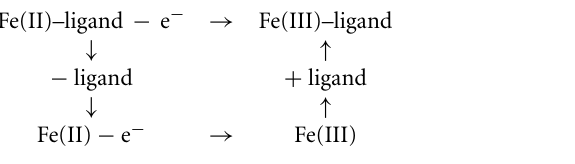
FIGURE 9 | Linear free-energy relationship in Fe(II)-complexes oxidation by